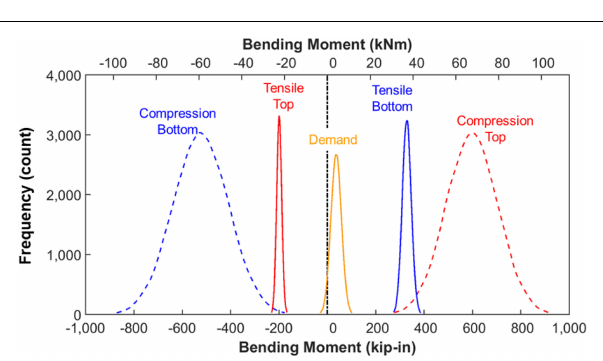
FIGURE 7 | Results from MCS of sleeper rail seat bending moments for HAL freight.